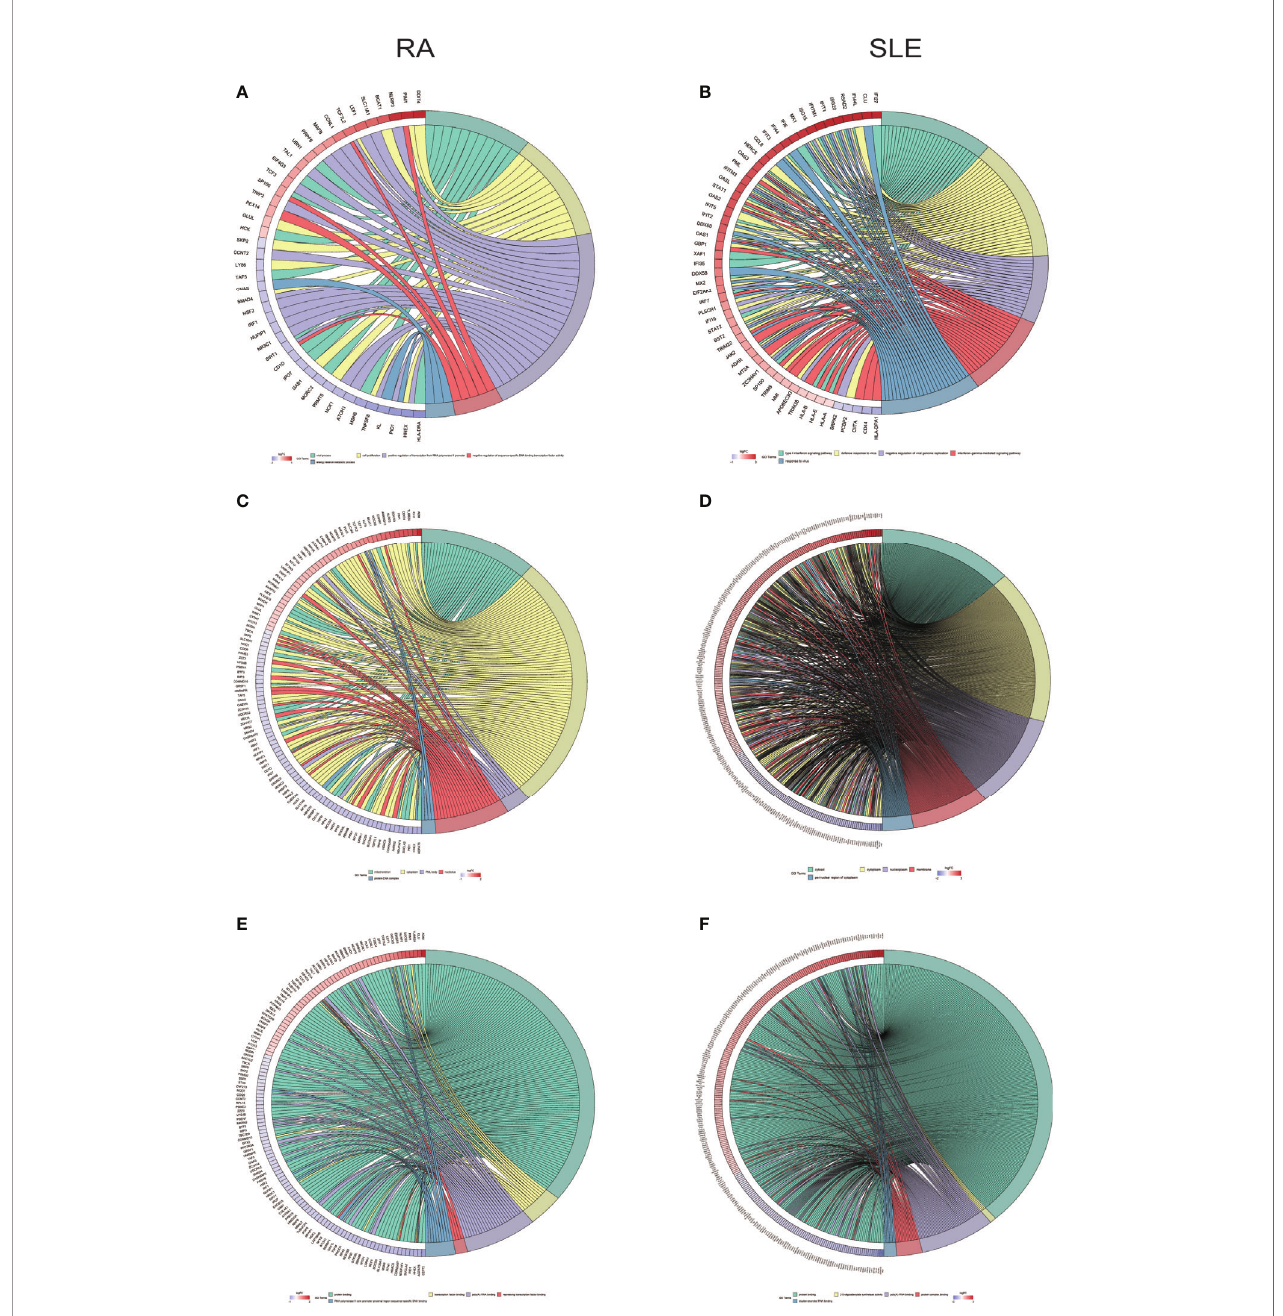
FIGURE 9 | Chord plot showing a relationship between aberrantly methylated DEGs of CD14 + monocytes between RA and SLE. (A) Top 5 GO terms of biological process in RA and (B) SLE; (C) Top 5 GO terms of cellular components in RA and (D) SLE; (E) Top 5 GO terms of molecular functions in RA and (F) SLE. GO, Gene